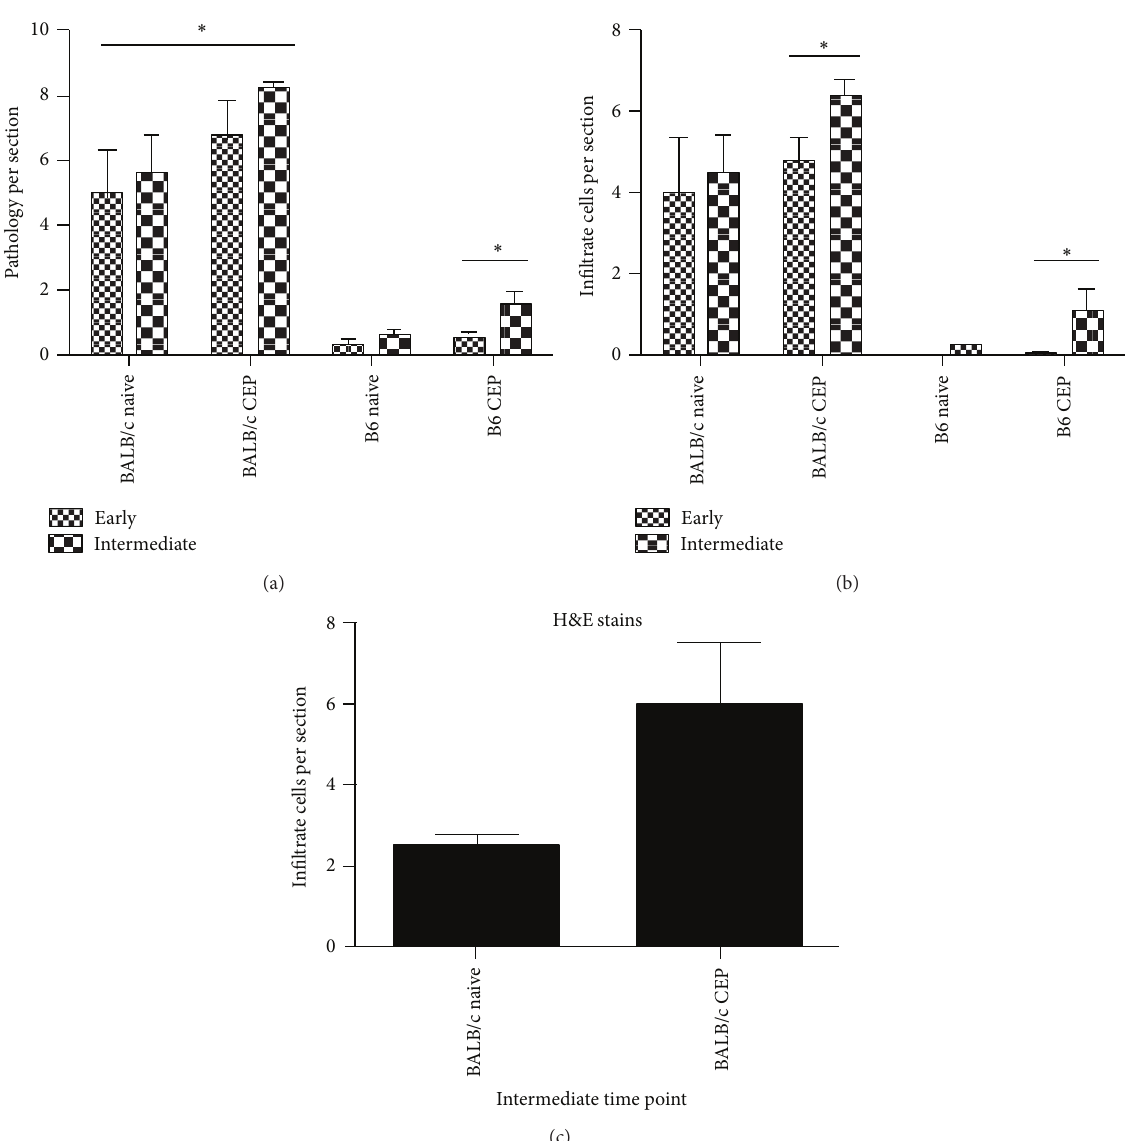
Figure 2: Quantification of retinal pathology and macrophage infiltration in CEP-MSA-immunized mice. (a) Combined pathology score per section (all kinds of lesions and IPM-infiltrating cells). The significant changes due to CEP-MSA immunization occur at the early time point in the BALB/c background, whereas they occur at intermediate time points for B6 mice. (b) CEP-MSA immunization accelerates IPM-infiltrating cell recruitment at early stages of AMD development, prior to major retinal damage. Mean values are shown; error bars represent S.D. ( ∗ ) denotes statistically significant differences ( 𝑃 < 0.05 ). Data from one representative experiment was used for this analysis; similar results were obtained in additional repeat experiments. (c) Haematoxylin & Eosin (H&E) staining of frozen sections confirmed the accelerated macrophage recruitment associated with CEP-MSA immunization. 5 sections were scored per mouse, with 3 mice per group at the intermediate time point (d 100–200 p.i.). Mean values are shown; error bars represent